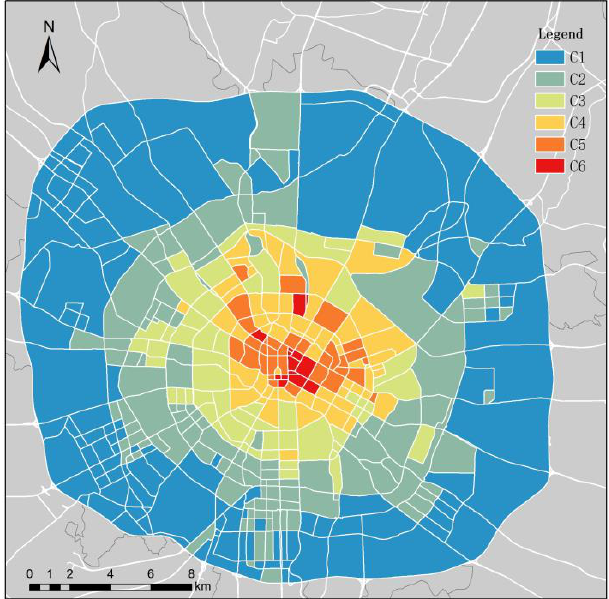
Figure 8. The results of k-nearest-neighbor–dynamic-time-warping (KNN¬–DTW).KNN-DTW classification based on the training samples was conducted on the remaining data to obtain the final result of the functional area classification.